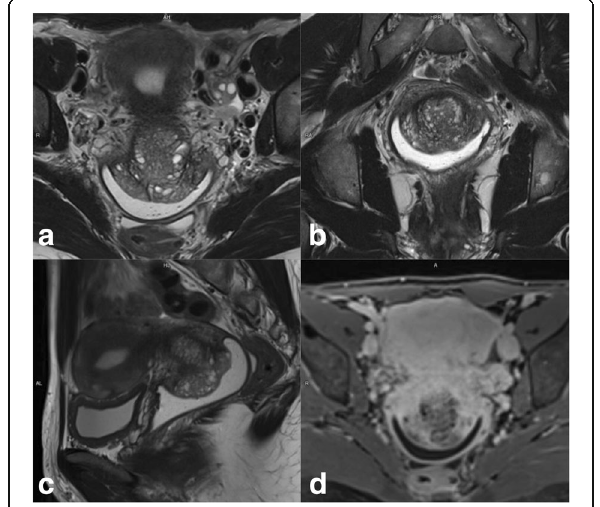
Fig. 20 Tunnel clusters visualized by axial oblique T2WI ( a ), coronal T2WI ( b ), sagittal T2WI ( c ), and DWI-ADC map ( d ). Clustered cystic spaces have a round or oval appearance, an absence of invasion of the deep cervical stroma, and no diffusion restriction (arrow in d )